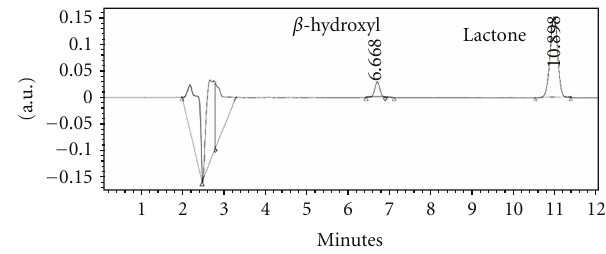
Figure 1: HPLC chromatogram of lovastatin in β -hydroxyl and lactone